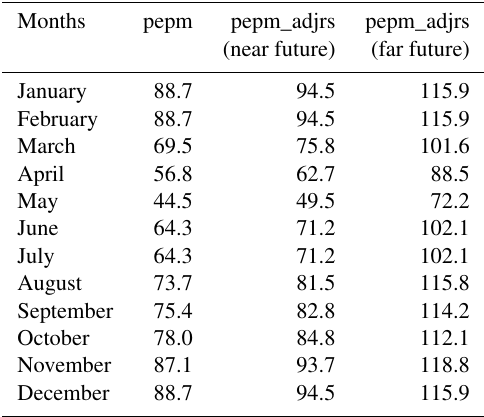
Table 4. Monthly surface resistance values ( r s , in sm − 1 ) used in the computation of E pot . The baseline values are shown under pepm and are kept constant in future time slices for variable pepm. pepm_adjrs denotes the future values accounting the changes in CO 2 concentration (see Sect. 3.3 for details).